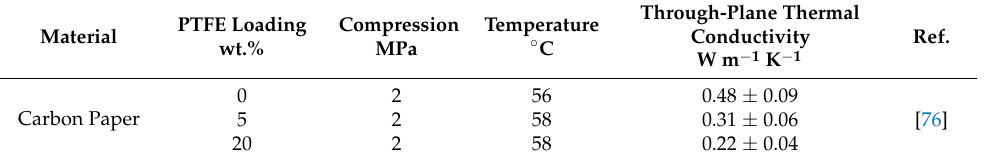
Table 2. Through-plane thermal conductivity values measured for GDLs with varying PTFE